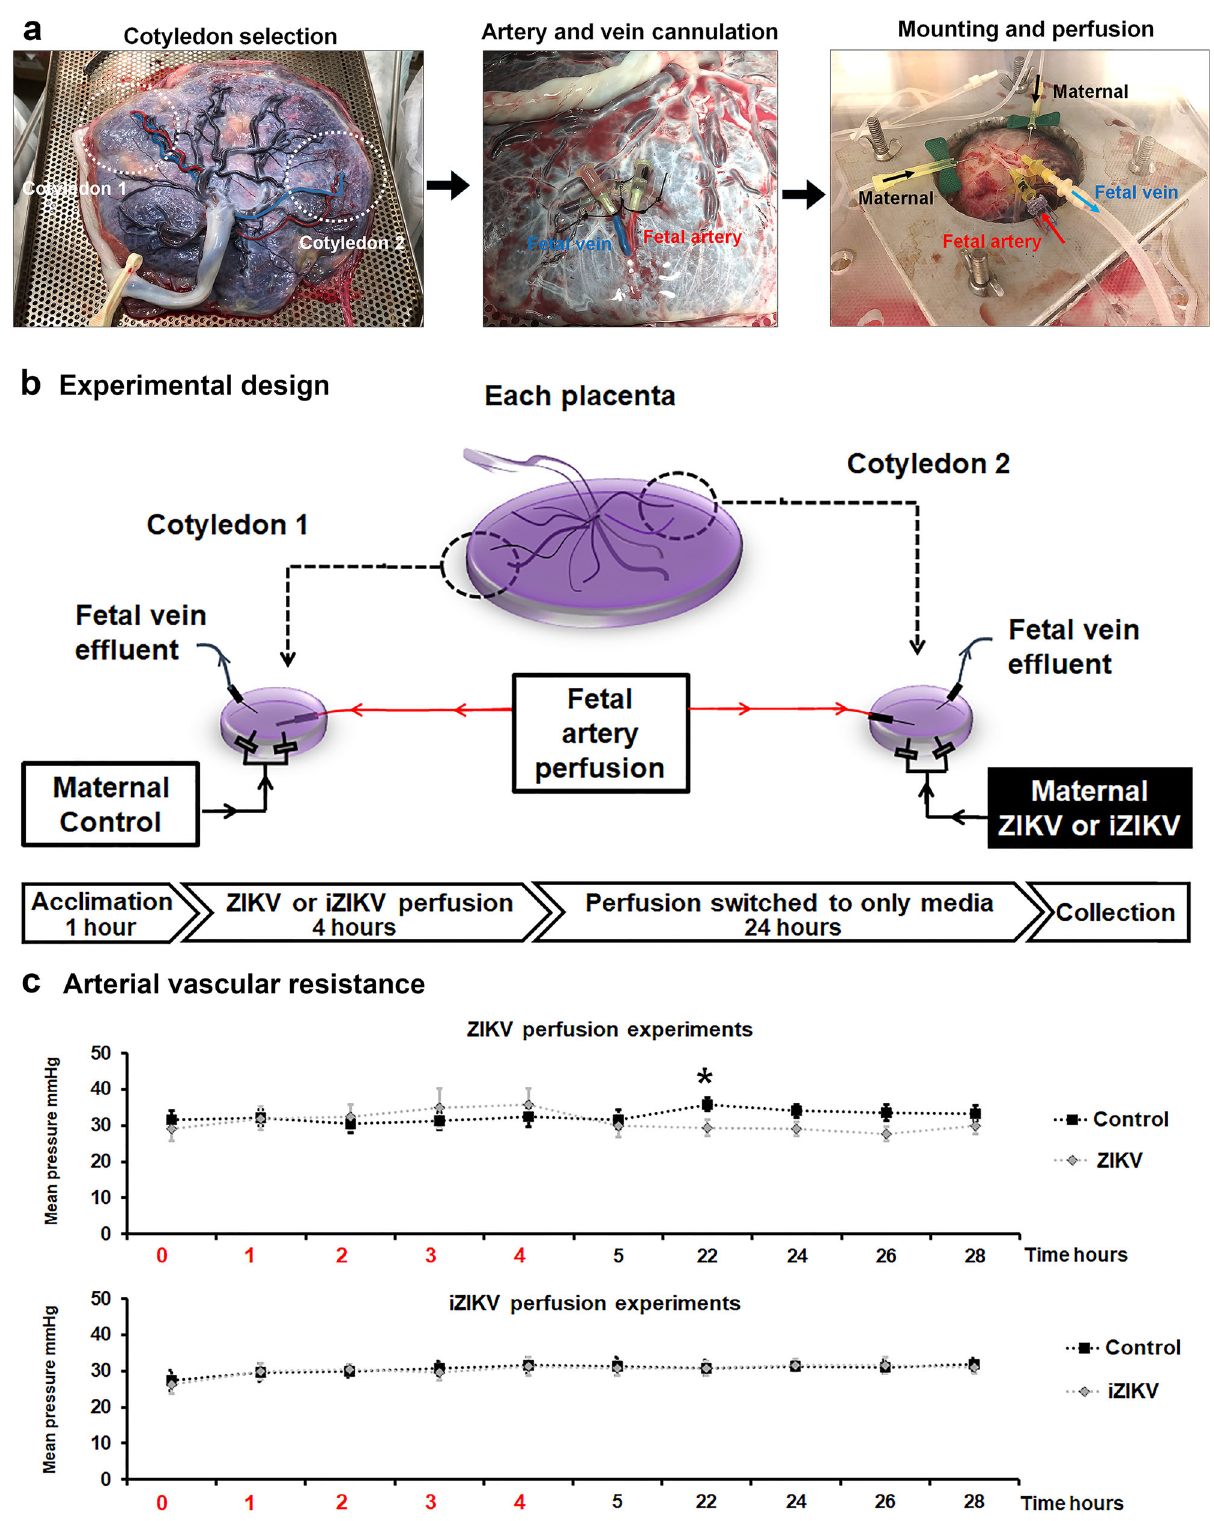
in fl ammation (CD163) from all perfusion experiments. CD163 is present on Hofbauer cells and released in soluble form with in fl ammation 30 . Thus CD163 staining may re fl ect placental Hofbauer cell numbers and their status. With ZIKV, more regions containing TUNEL + nuclei are visible (Fig. 6a) 31,32 . A signi fi cant increase of TUNEL + cells occurs with ZIKV exposure